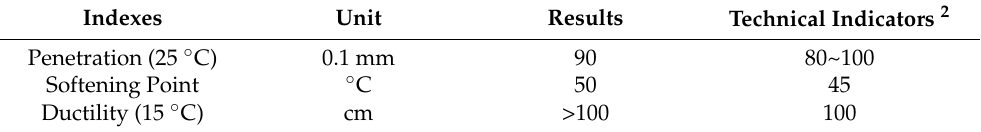
Table 2. Main technical indexes of styrene-butadiene styrene block copolymer (SBS) modified asphalt.